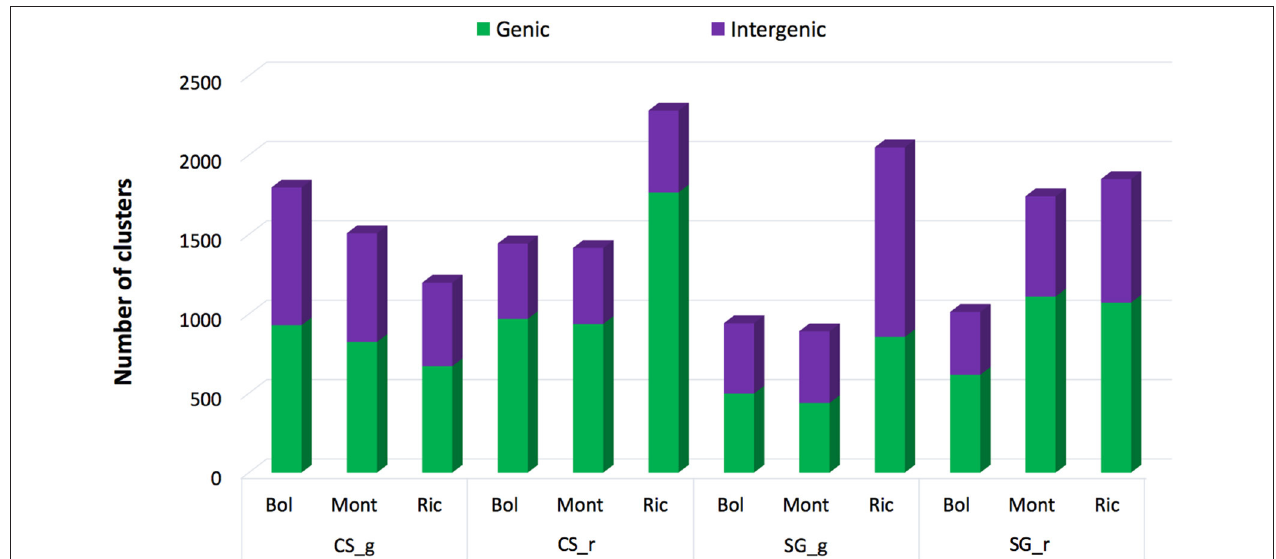
FIGURE 1 | Number of small RNA clusters expressed in ripened and green berries of grapevine collected from 2 different cultivars growing in 3 vineyards. The proportion of clusters located in Genic and Intergenic regions (based on the V1 grapevine genome annotation) is shown in green and blue respectively. CS, Cabernet Sauvignon; SG, Sangiovese; g, green; r, ripened; Bol, Bolgheri; Mont, Montalcino; Ric, Riccione. Green corresponds to bunch closure and ripened corresponds to 19 ◦ Brix developmental